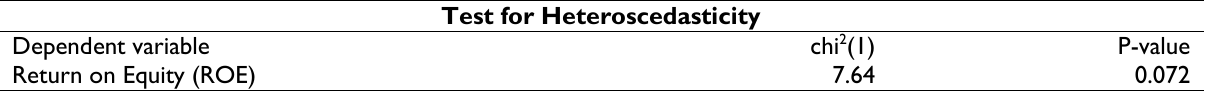
Test for Heteroscedasticity